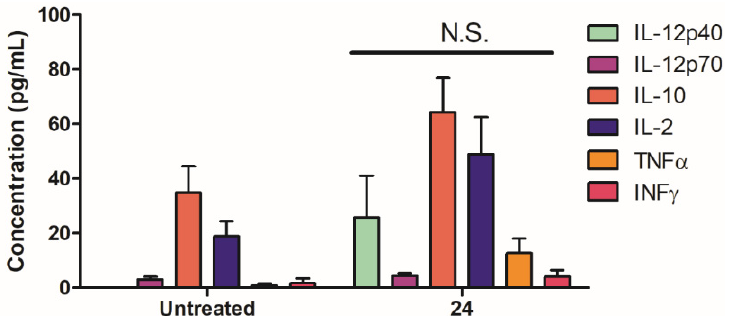
Figure 6. Immunogenicity assessment mannosylated liposomes assembled with 24. Immune responses in PBMCs (isolated from 3 healthy volunteers) were measured. PBMCs were seeded at 10 6 cells/mL and left untreated or treated with 24 (10 µ g/mL). Cells were incubated for 48 h and supernatants were analyzed for the production of cytokines by ELISA. Statistical analysis in the form of an unpaired T-test was performed using GraphPad Prism and no significance (N.S.) was observed between the untreated and 24 treated groups for each respective cytokine.